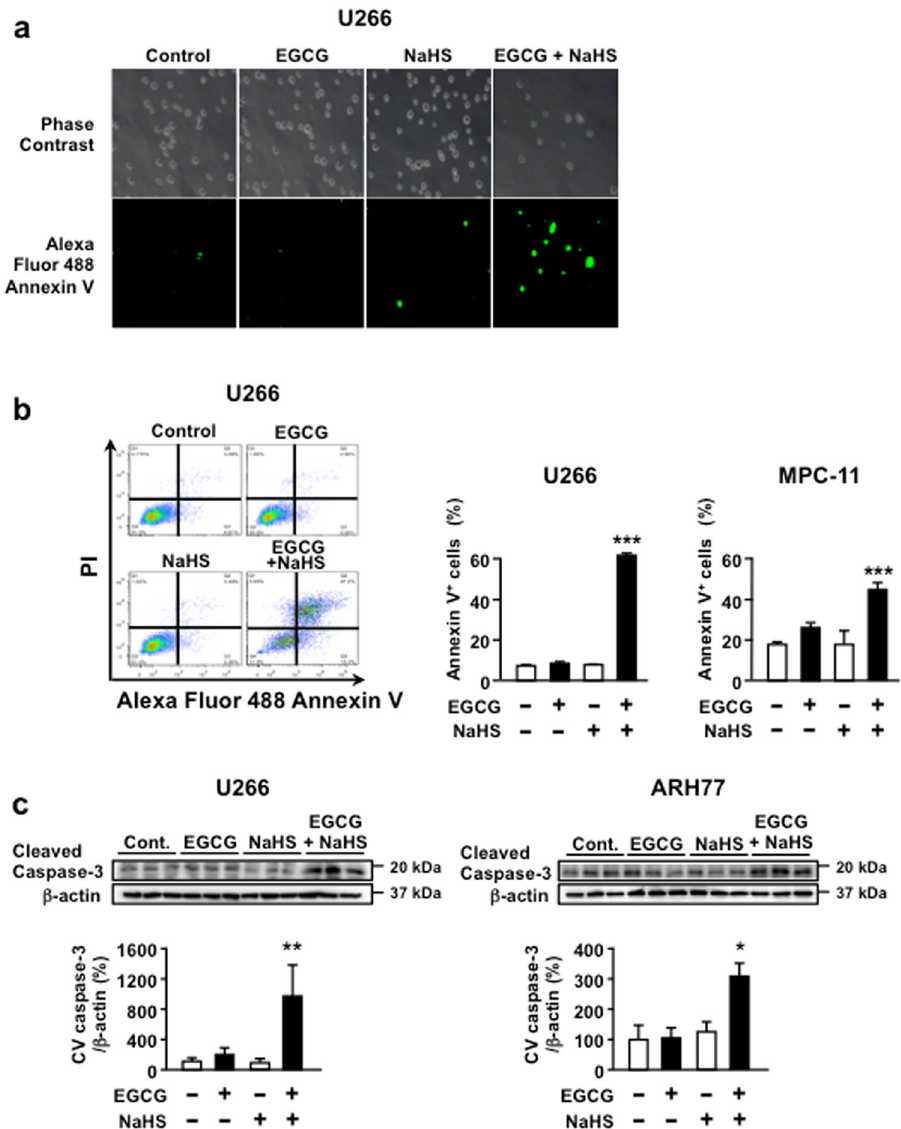
Figure 2. Combination of EGCG and NaHS induces apoptosis in MM cells. ( a ) U266 cells are treated or not treated with 5 μ M EGCG in the presence or absence of 10 μ M NaHS for 96 h and are observed under a florescence microscope. ( b ) Apoptotic cells are double stained with PI and Annexin V–Alexa Fluor 488 in U266 and MPC-11 cells. ( c ) U266 and ARH77 cells (human MM) are treated or not treated with 5 μ M EGCG in the presence or absence of 10 μ M NaHS for 72 h, and cleaved caspase-3 levels are assessed using western blot analysis. Cropped gels/blots are displayed. Full-length gels/blots are included in the Supplementary Information (Supplementary Fig. 7). Data are presented as mean ± SEM ( n = 3). ** P < 0.01, *** P <